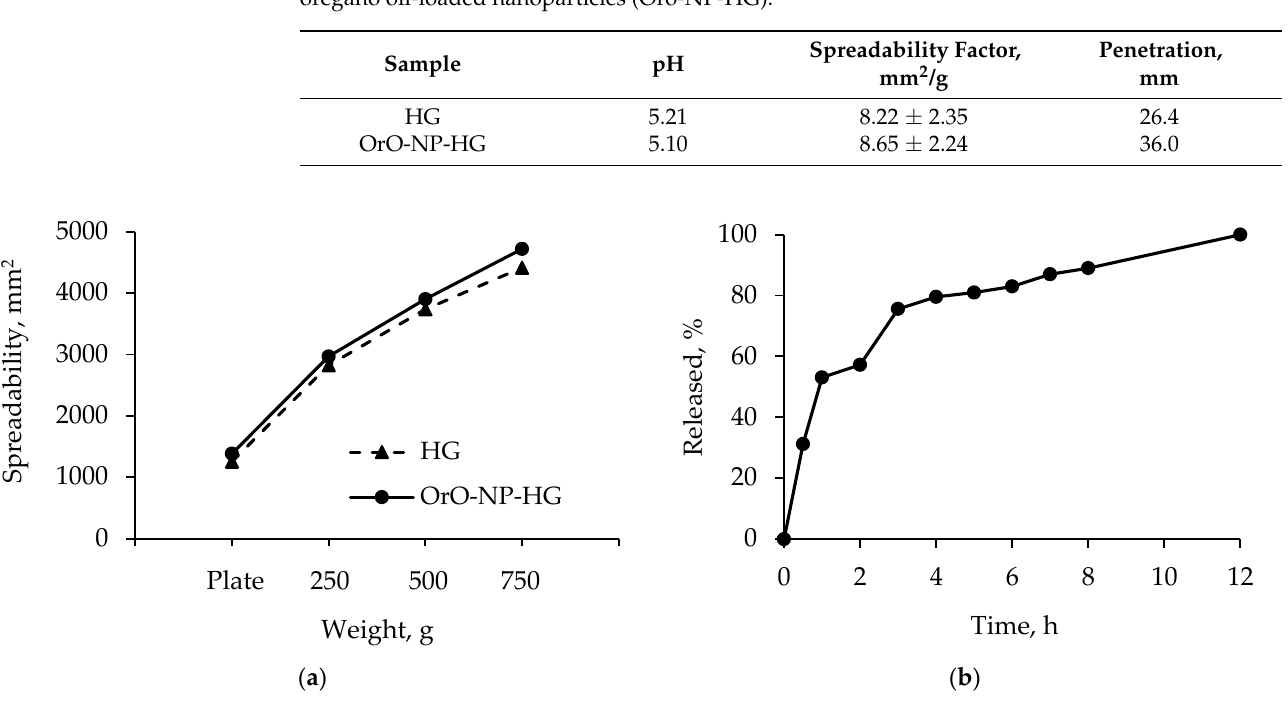
Table 2. Minimal inhibitory concentrations of hydrogels with OrO-NP, gentamicin or ciprofloxacin after single application. Bacterial Species